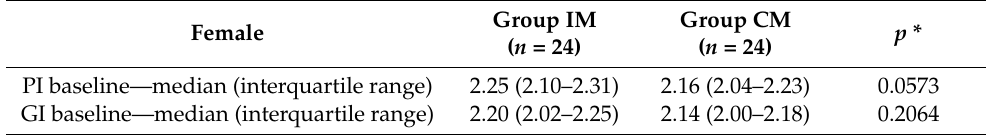
Table 5. Median (interquartile range) of PI and GI at baseline in female